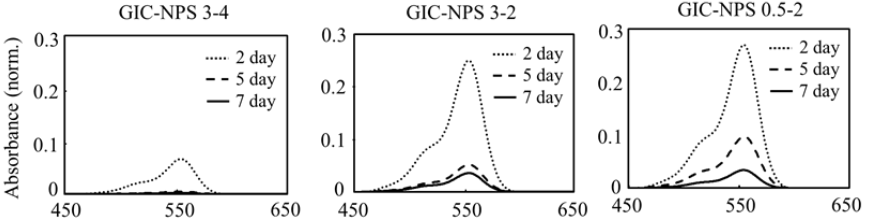
Figure 2. The absorption spectra of the supernatants in which GIC–NPS3-4, GIC–NPS3-2, or GIC– NPS0.5-2 were immersed for 2, 5, and 7 days.